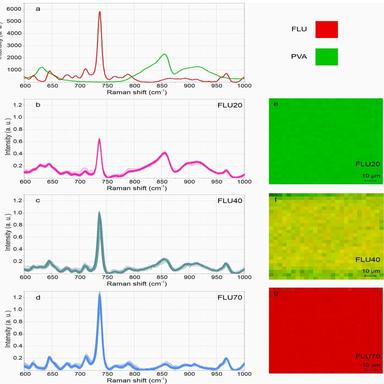
Reference Raman spectra of FLU and PVA (a). Raman spectra (b-d) and maps (e-g) of the tablets made of FLU20, FLU40, and FLU70 filaments. Pure red and pure green color denote pure FLU and pure PVA, respectively. (For interpretation of the references to color in this figure legend, the reader is referred to the web version of this article.)